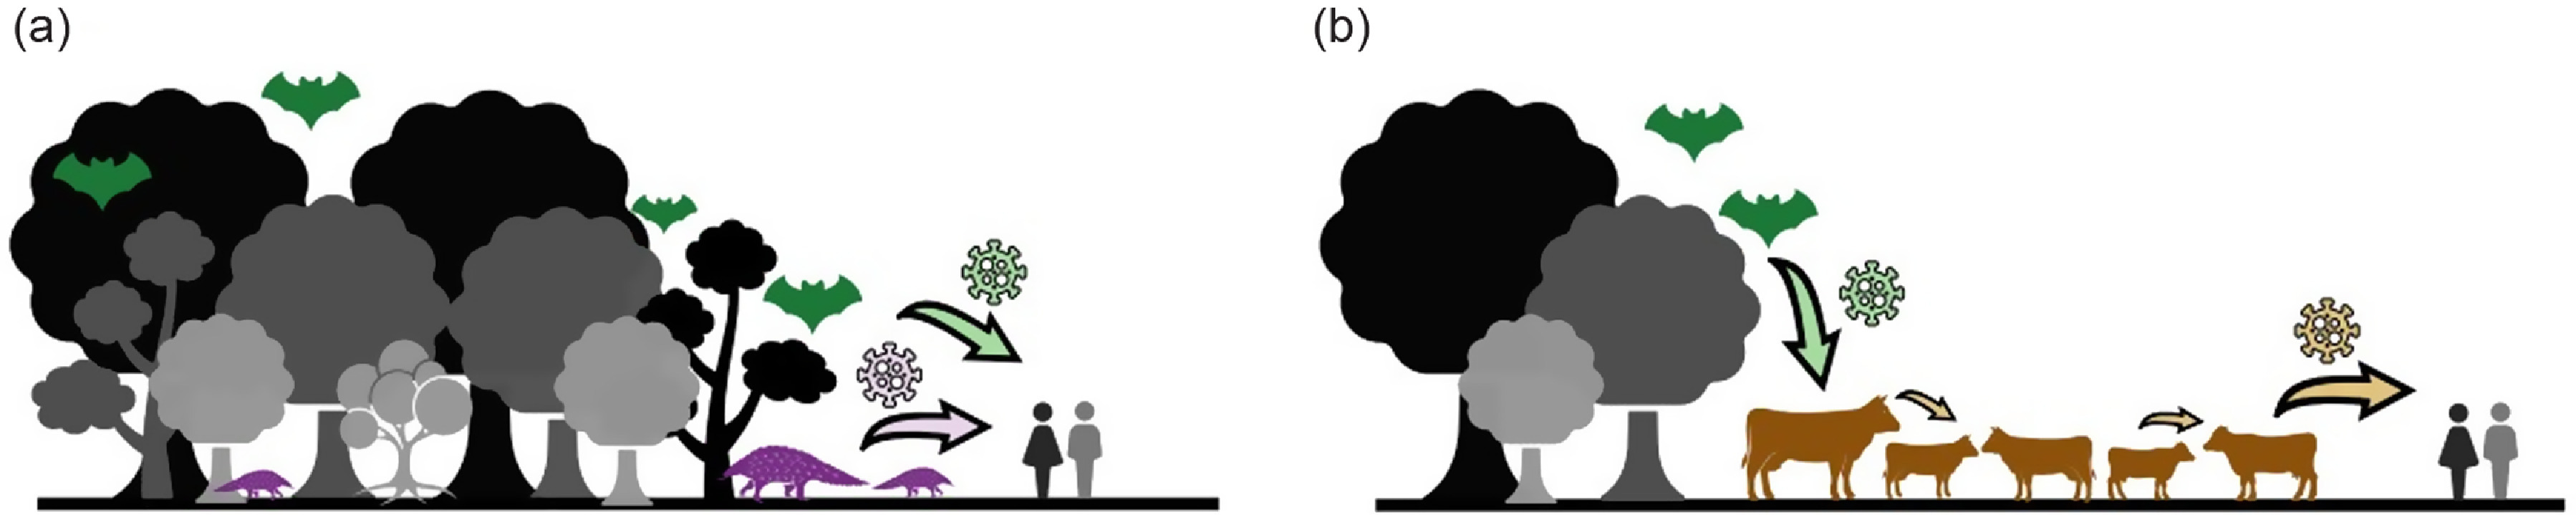
The path of the virus from the wild ecosystems to human beings. (a) Wildlife consumption; (b) intensive husbandry